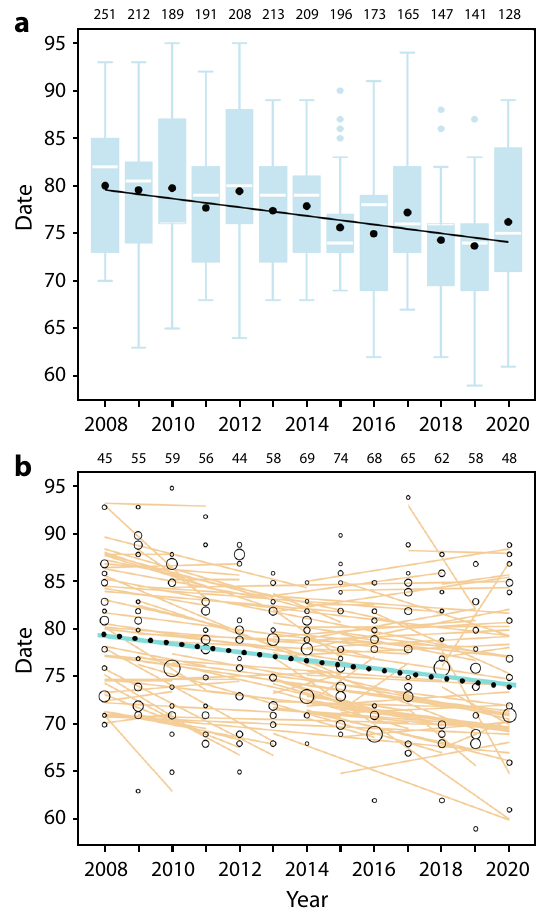
Fig. 2 Advancement in godwit migratory departure from New Zealand during 2008 – 2020, at the population and individual levels. a Population- level advancement in departure. In blue: distribution of departures ( n = 128 – 251 godwits per year, total = 2,423 departures; sample sizes above panel); boxplots indicate 25 – 75th percentile range with median departure date (white lines); whiskers extend to 1.5× interquartile range; outliers (dots) beyond this. In black: mean departure dates ( fi lled circles) plus linear slope (solid line). Date: 1 = 1 January. b Within-individual advancement of departure date ( n = 124 marked individuals observed in 3 – 13 years each; sample sizes above panel). Open circles = all departures; size scaled to the proportion of total migrating individuals that year (0.006 – 0.422 per day). Orange lines indicate within-individual slopes. Overall advancement was shown by the solid blue line (within-individual slope) and black dotted line (between-individual slope); see Supplementary Table